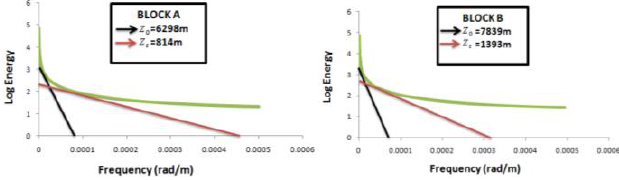
Figure 13: Spectral plots of logarithm of Energy against Frequency The gradient of each of the line segments were first evaluated and the depth to Centroid, Z 0 (black line) and depth to top boundary, Z t (red line) were calculated. The Curie point depth ( 𝑍 𝑏 ), thermal gradient ( dT ) and the dZ heat flow (q) of the study area were calculated (Table 1). The 2D Curie isotherm depth (Figure 14), the geothermal gradient and heat flow contour maps of the study area (Figures 15 and 16) respectively were generated. Figure 15shows the Curie point depth of the study area to range from 12km to 18km. This reveals that the deepest curie point depth lies at the north east while the shallowest is found at the south western part of the study area. The geothermal gradient ranges from 32.137 ° C/km to 49.231 ° C/km with an average value of 39.317 ° C/km (Table 1) indicating